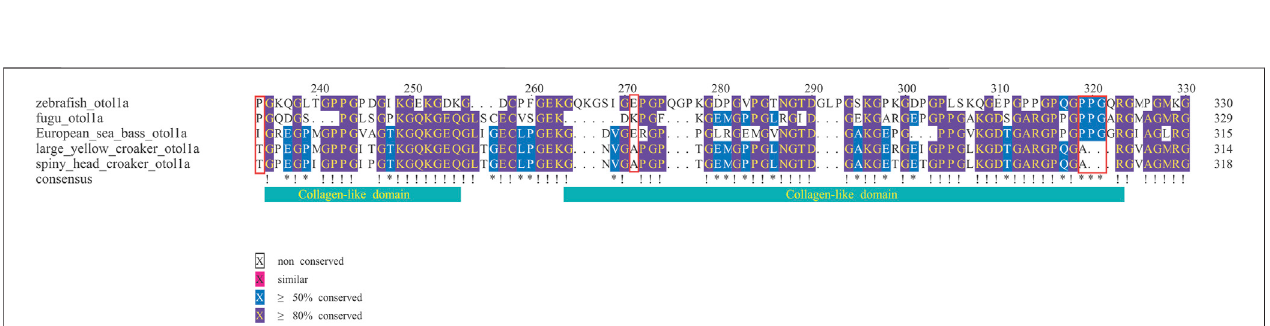
FIGURE 8 | Multiple alignments of partial Otol1a sequences. Red boxes mark the changed amino residues at the collagen-like domain of Otol1a from the family Sciaenidae.